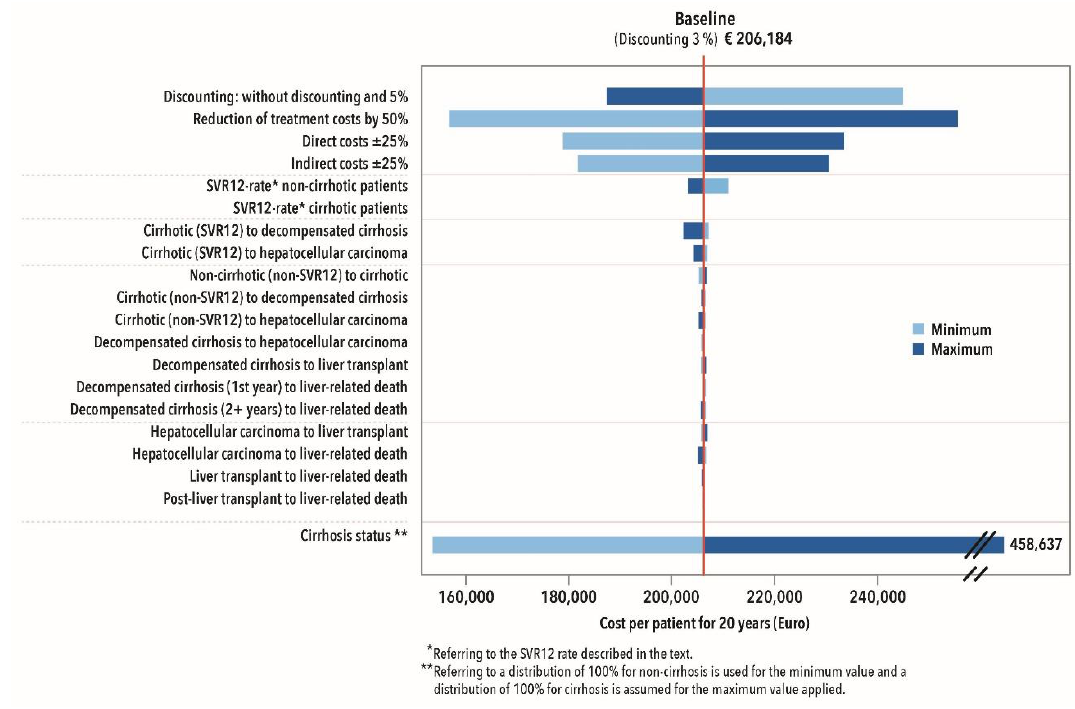
Figure 4. Deterministic sensitivity analysis of DAA therapies.